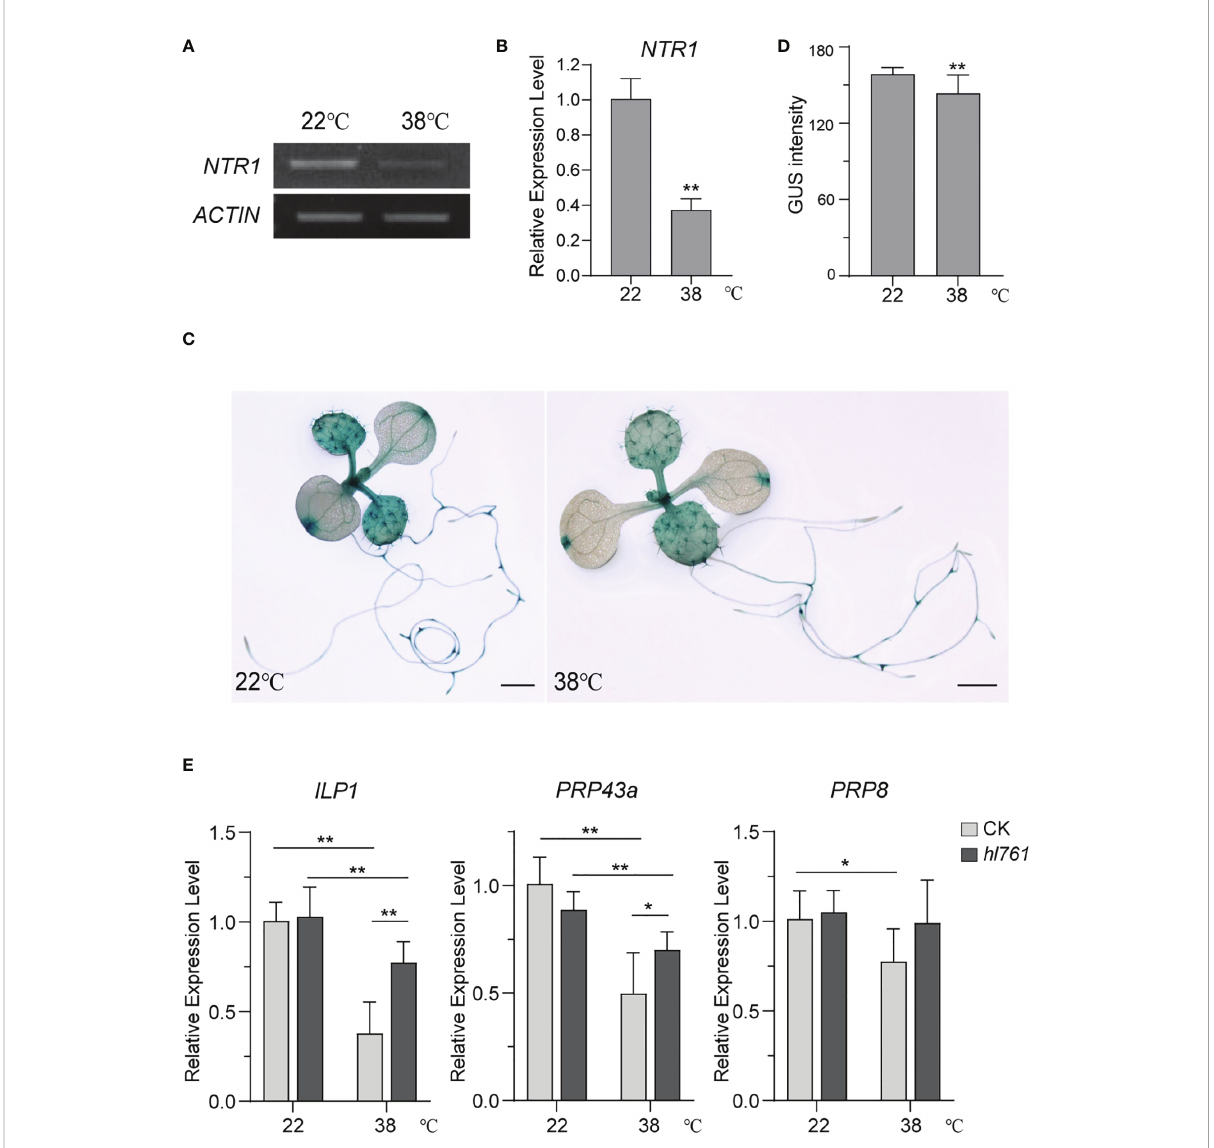
FIGURE 10 HS suppresses the expression of NTR1 and other components of the NTR1-associated complex. (A) Semi-quanti fi cation of the expression of NTR1 upon 1-h heat treatment at 38°C. (B) The expression of NTR1 upon 1-h heat treatment at 38°C quanti fi ed by qPCR. The expression is relative to that of untreated samples. Error bars indicate the SD of three biological replicates. Asterisks indicate statistically signi fi cant differences (**p < 0.01 in Student ’ s t-test). (C) b -Glucosidase (GUS) staining of pNTR1:GUS transgenic plants with (right) or without (left) 38°C 1-h heat treatment. Bar = 1 mm. (D) Quanti fi cation of GUS intensity for plants in panel (C) Error bar stands for SD, n = 20. Asterisks indicate statistically signi fi cant differences (**p < 0.01 in Student ’ s t-test). (E) Relative expression of ILP1 , PRP43a , and PRP8 in 38°C 1-h heat-treated seedlings of CK and hl761 . The expression is relative to that of CK without heat treatment. Error bars indicate the SD of three biological replicates. Asterisks indicate statistically signi fi cant differences (*p < 0.05, **p < 0.01 in Student ’ s t-test). CK, background line for hl761 ; HS, heat